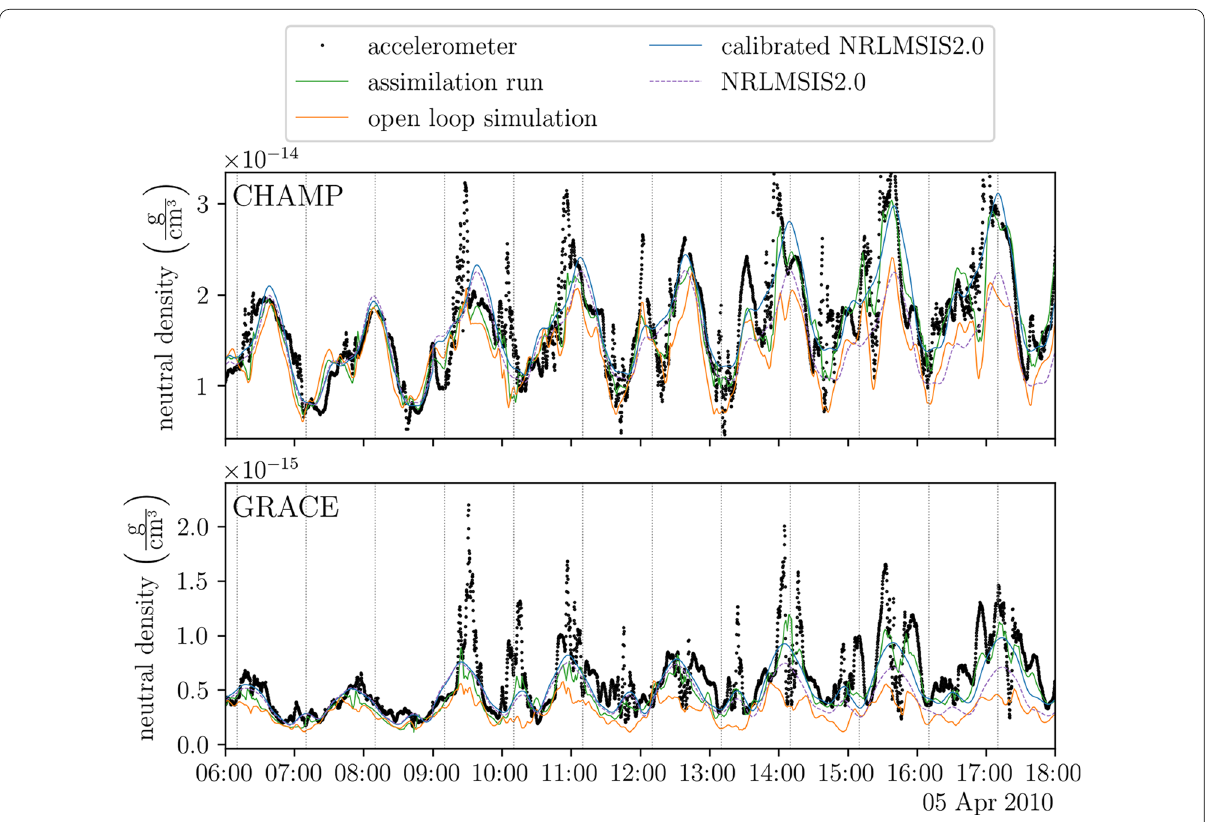
Fig. 11 Densities along the orbits of CHAMP and GRACE from various sources. The x axis is limited to a period where KP is always larger than or equal to 5 and contains the largest KP value of 7 2 3 in the experiment (9:00–12:00). The dotted vertical lines mark the analysis